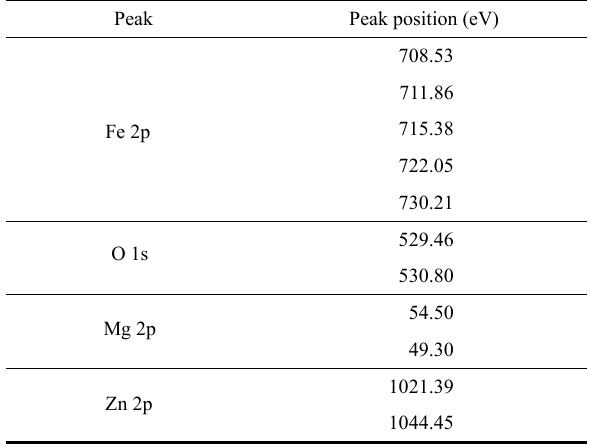
Table 9 Peak positions of fitted of Fe 2p, O 1s, Mg